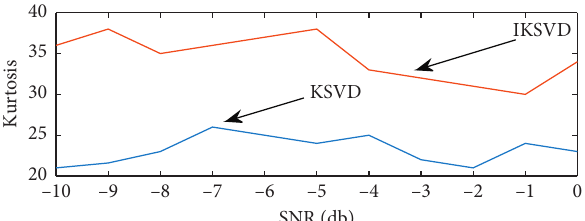
Figure 5: The kurtosis of the reconstructed signal by using IKSVD and traditional